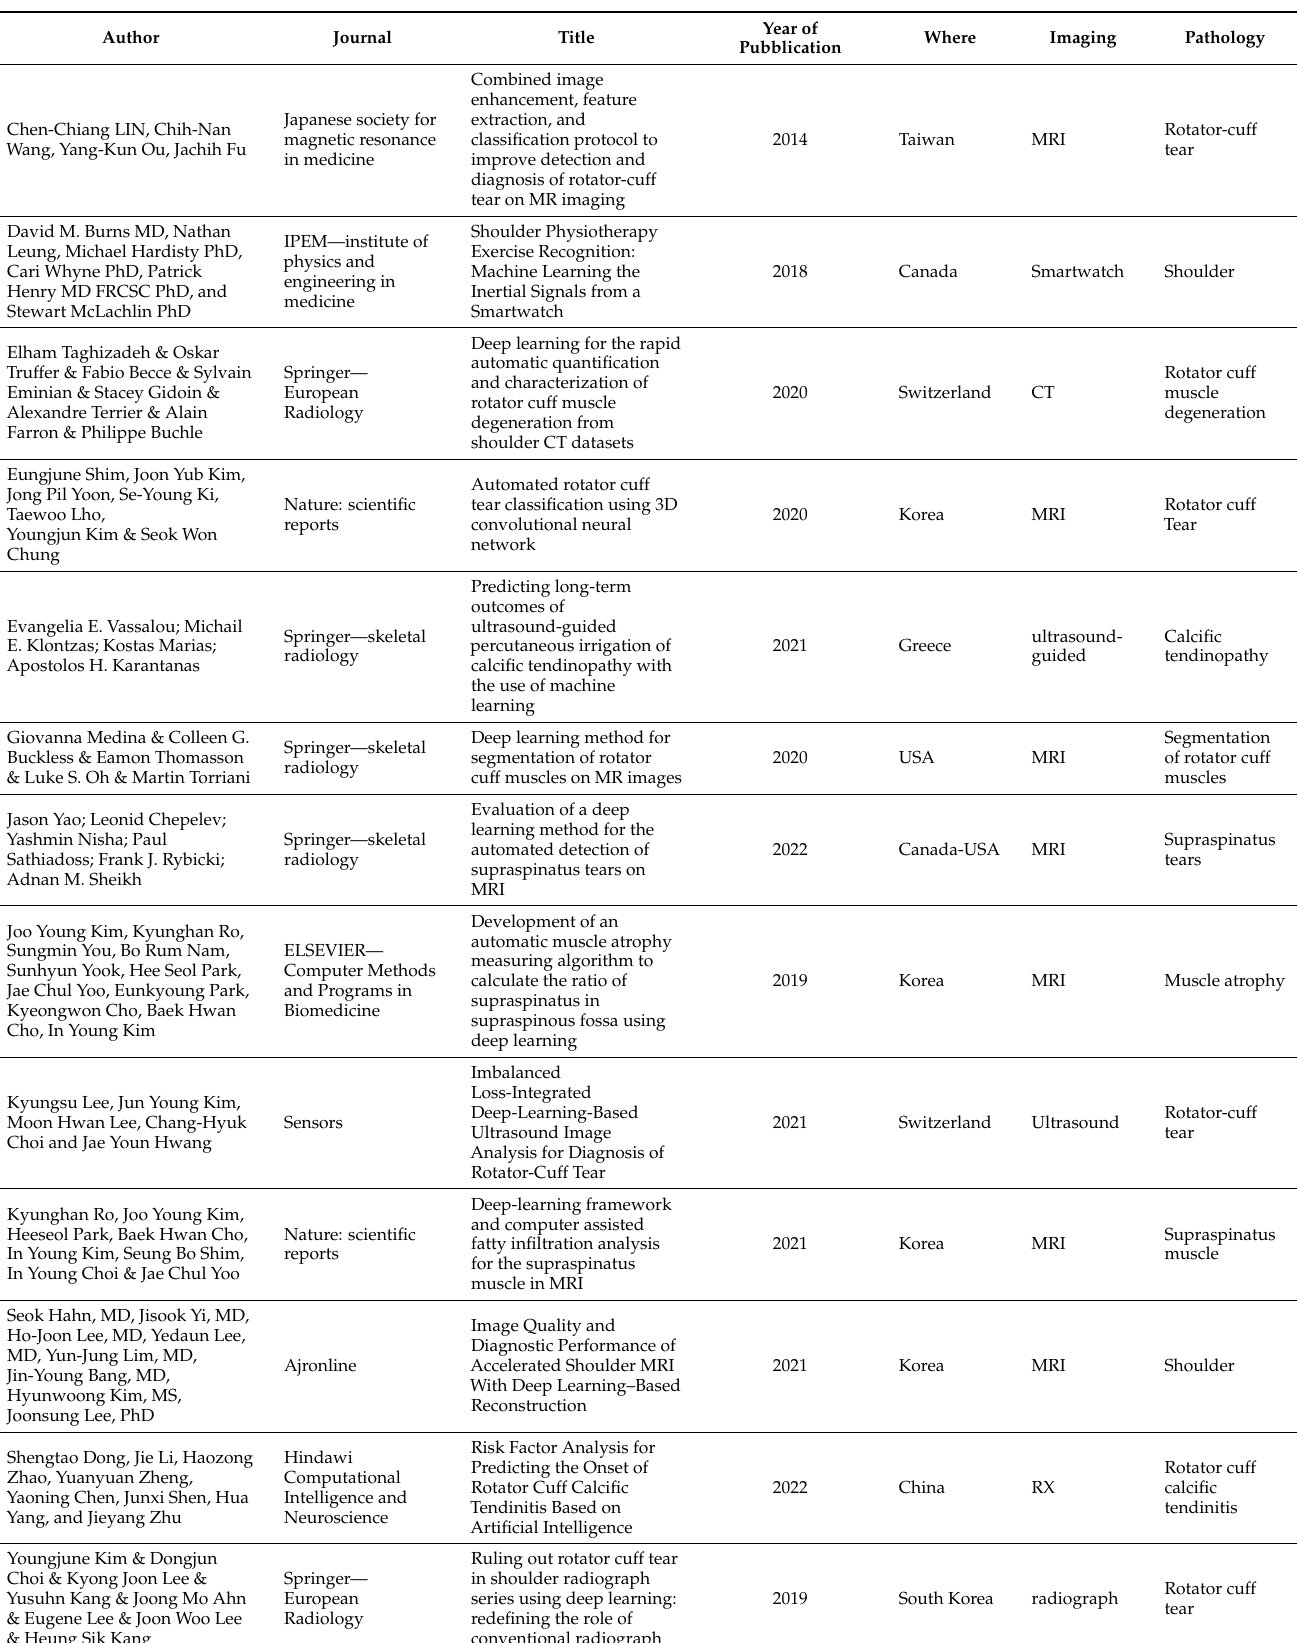
Table 1. Characteristics of studies on artificial intelligence in rotator cuff